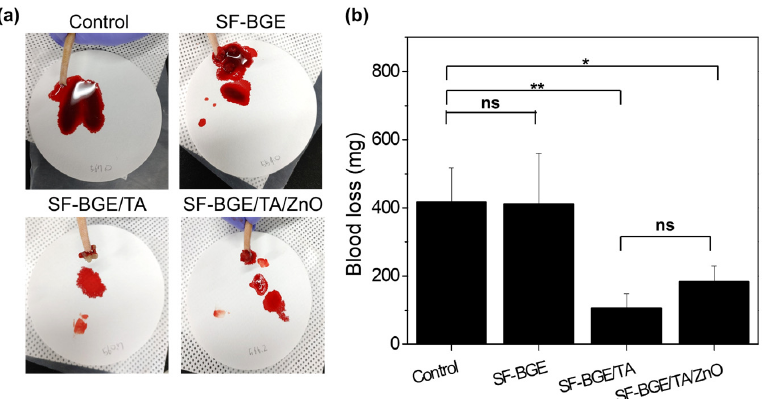
Figure 5. ( a ) Photographs of blood loss after tail amputation and administration of SF-BGE, SF- BGE/TA and SF-BGE/TA/ZnO hydrogel. ( b ) Blood loss (mg) from injury rat tail of control, SF-BGE, SF-BGE/TA, and SF-BGE/TA/ZnO hydrogel. The results are reported as the mean ± standard deviation (n = 3). Statistical significance was analyzed by one-way ANOVA and Tukey’s post hoc test (* p < 0.05, ** p <